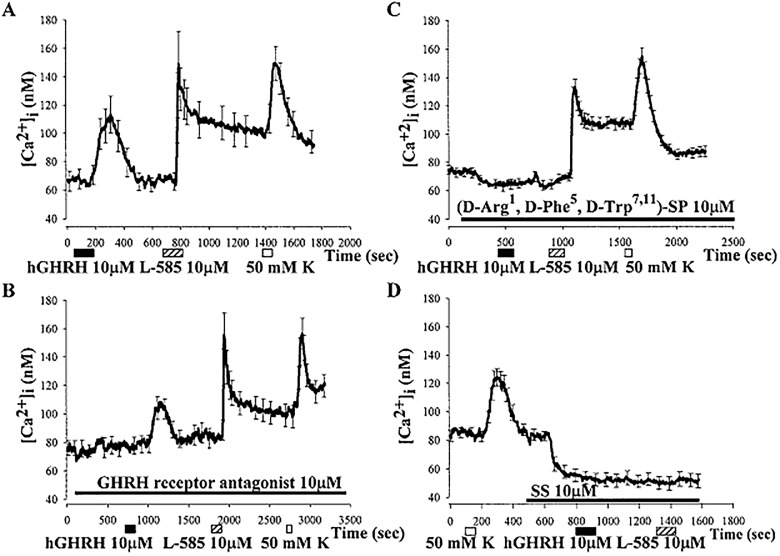
Intracellular calcium [Ca2+]i nM concentrationafter exposure to hGHRH to identify GH secreting cells, and followed by exposure to 10 mm L692,585(A). In the presence of GHRH receptor antagonist [Ca2+]i nM concentration is greatly decreased whereas L692,585 calcium transit remains robust (B). Intracellular calcium [Ca2+]i nM concentration after exposure to hGHRH to identify GH secreting cells, and followed by exposure to 10 mM L692,585. Substance P analogue [(D-Arg1,D-Phe5, D-Trp7,11]-SP-blocked the effect of GHRH, but not the stimulatory effect of L-692,585 on intracellular calcium response (C). Somatostatin (SS) completely blocked the effect of L692,585 on intracellular Ca2+ concentration. In the presence of a specific receptor antagonist to the GHS-R, the response of [Ca2+]i to L692,585 was dampened (D).